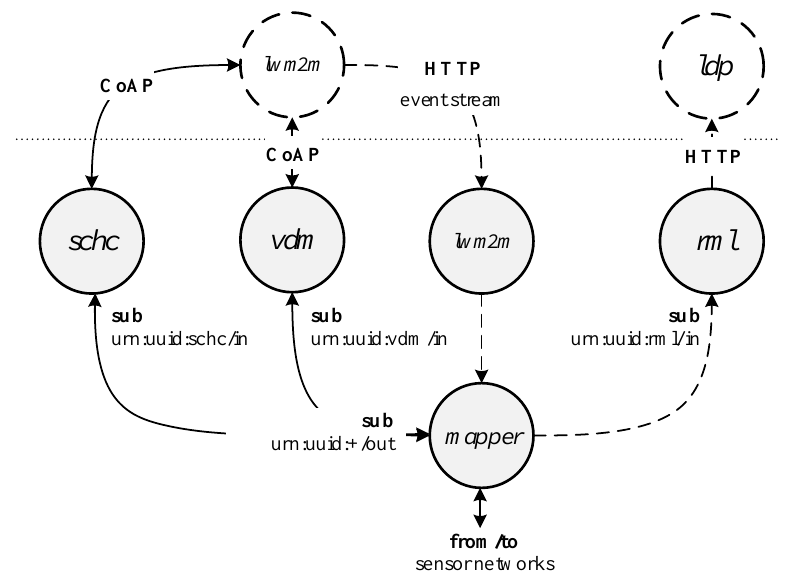
Figure 7. FLINT configuration that provides semantic and platform interoperability. Packets from the LPWANs are delivered to the LwM2M server. Data from the LwM2M server are mapped to an ontology that matches the semantics of the